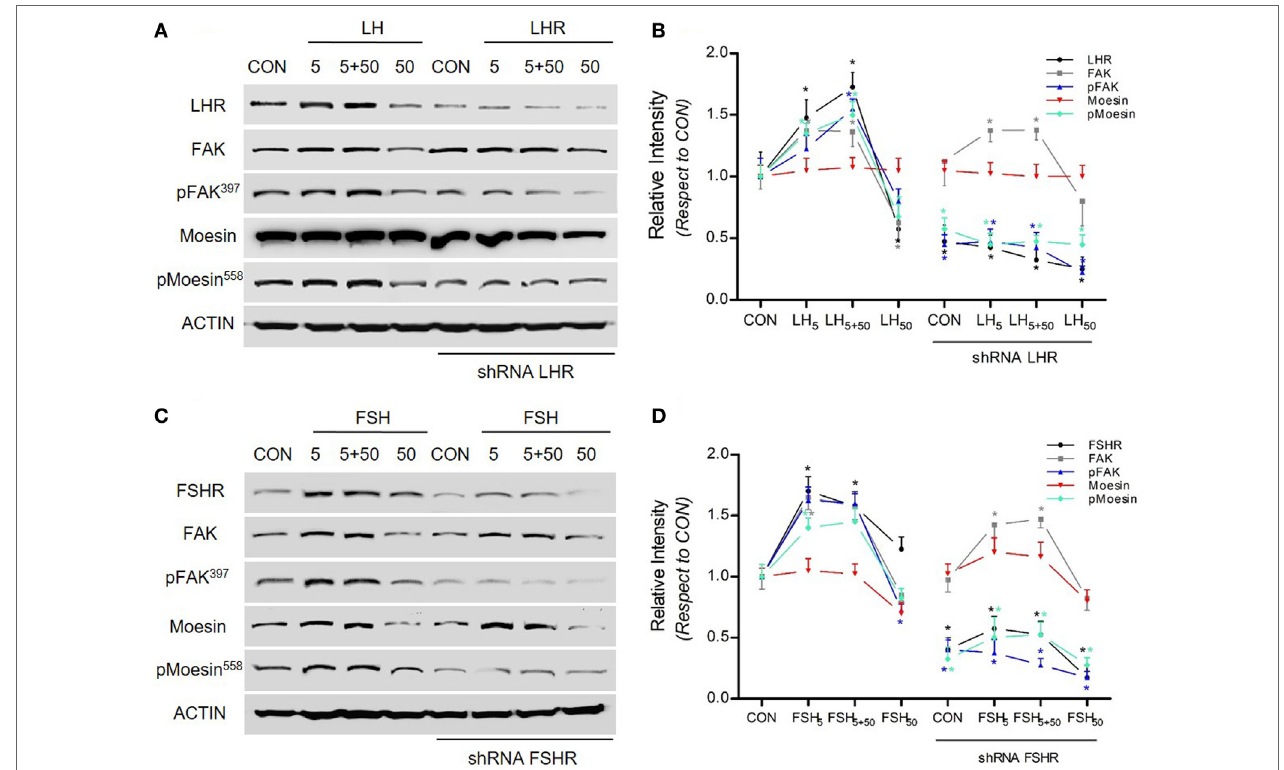
FigUre 3 | LH/follicle-stimulating hormone (FSH) signal to moesin and focal adhesion kinase (FAK) via LHR/follicle-stimulating hormone receptor (FSHR). (a–c) T-47D breast cancer cells were transfected with shRNA vs. LHR and FSHR (shRNA LHR and shRNA FSHR) or with vehicle, and protein analysis for LHR, FSHR, actin, wild-type (FAK and moesin), or p-FAK and p-moesin was performed on cell lysates after treatment with LH and FSH in different concentrations (5, 5 + 50, and 50 mUI/ml) for 48 h. (B,D) The graphs display the quantitative analysis of the intensity of the bands, obtained as number of photons measured by the ChemiDoc digital imaging system and evaluated with the Quantity One Software